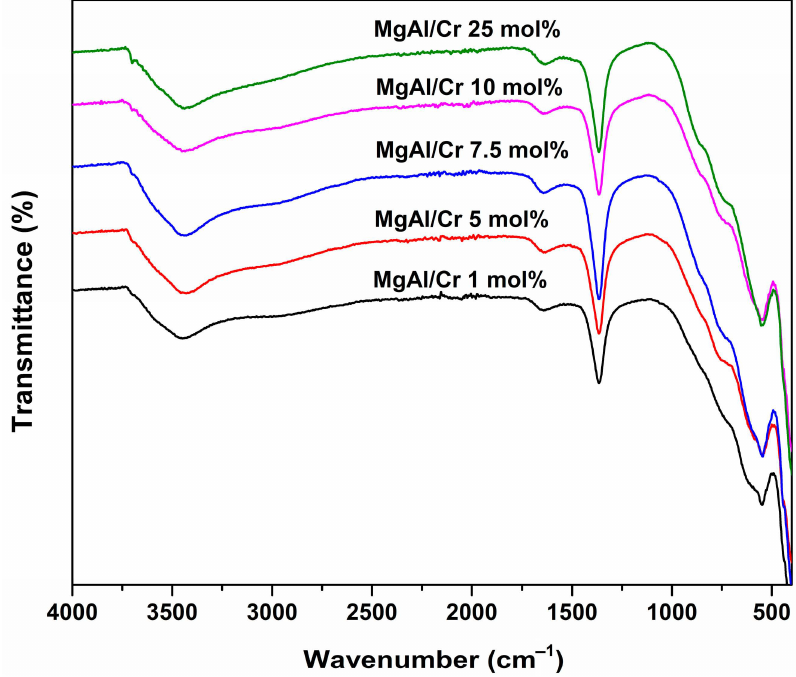
Figure 2. The Fourier transform infrared (FT-IR) spectra of Cr-substituted Mg 3 Al 1 − x Cr x